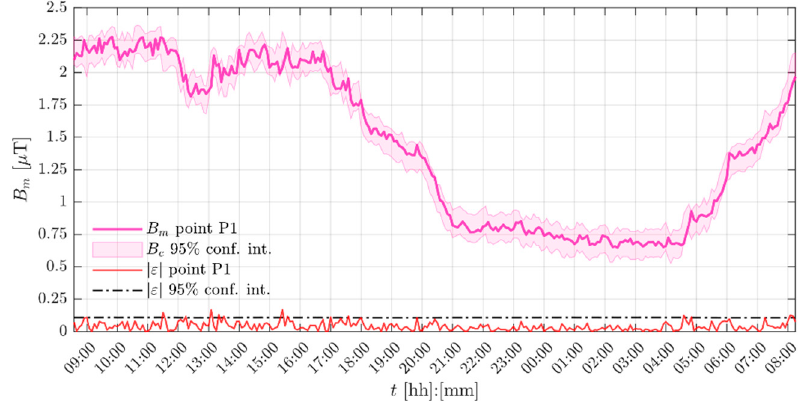
Figure 9. Position P1 measured field evolution over the 24 h (solid pink like) and its predicted 95% confidence interval (filled area). The absolute value of the residuals (red trace) is well confined by the confidence interval sideband (dash-dot line).